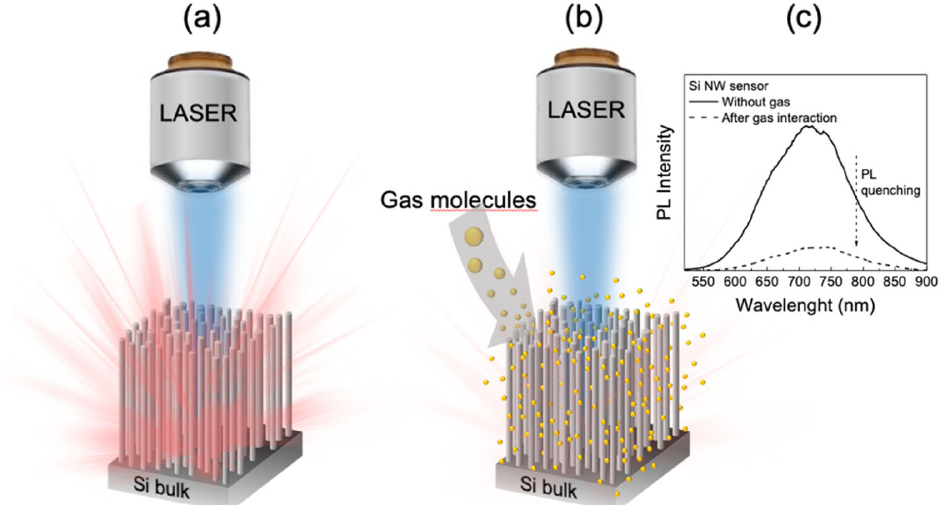
Figure 2. Schematic representation of the Si NWs PL variation before ( a ) and after ( b ) gas particles infiltration of inside the Si NWs matrix. ( c ) Visualization of the photoluminescence band quenching phenomenon following an interaction between Si NWs and a generic gas target.